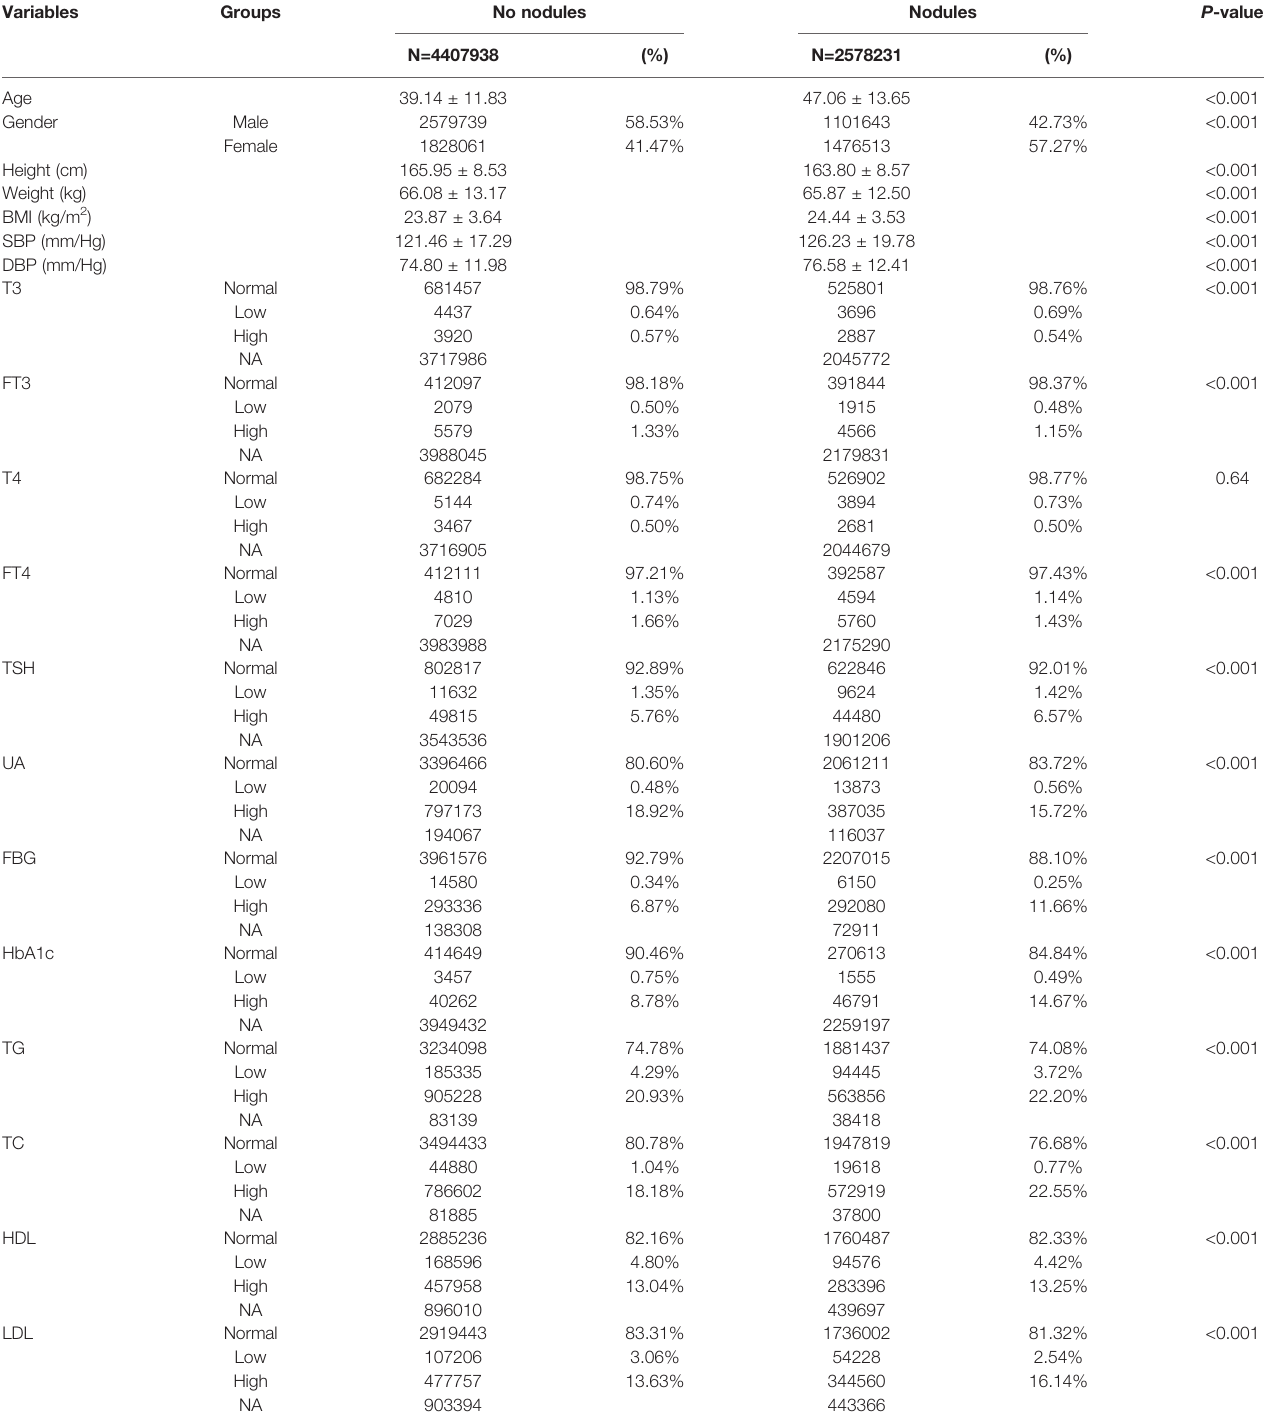
TABLE 1 | Distribution of sociodemographic characteristics and blood factors among subjects with and without thyroid